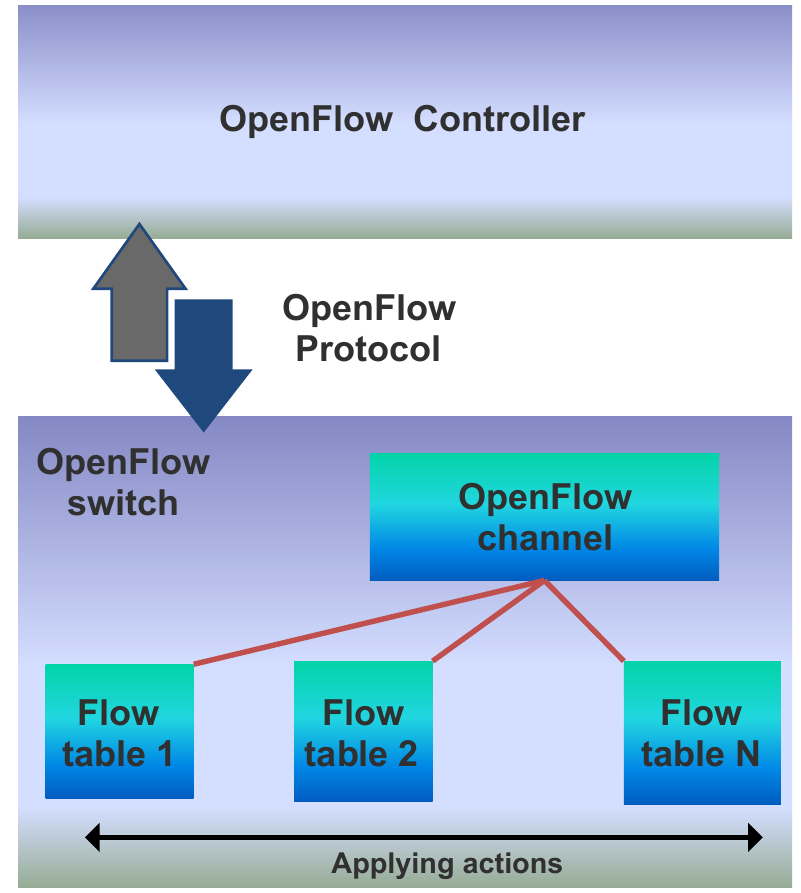
Figure 3. OpenFlow